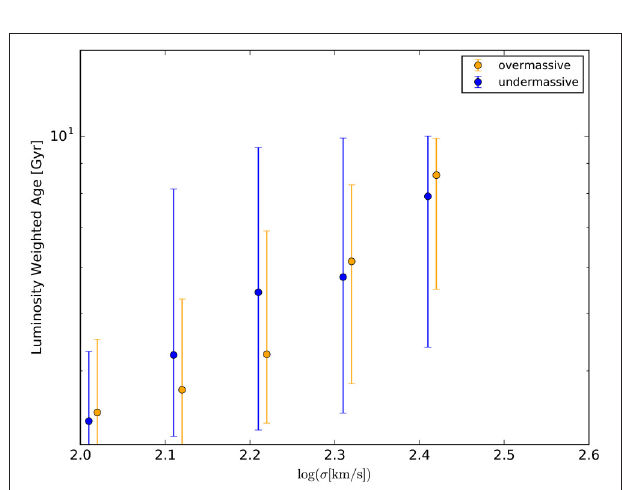
FIGURE 4 | The same figure as Figure 3 with weak AGN feedback model: the parameter, α cool , is 0.1 times smaller than the fiducial